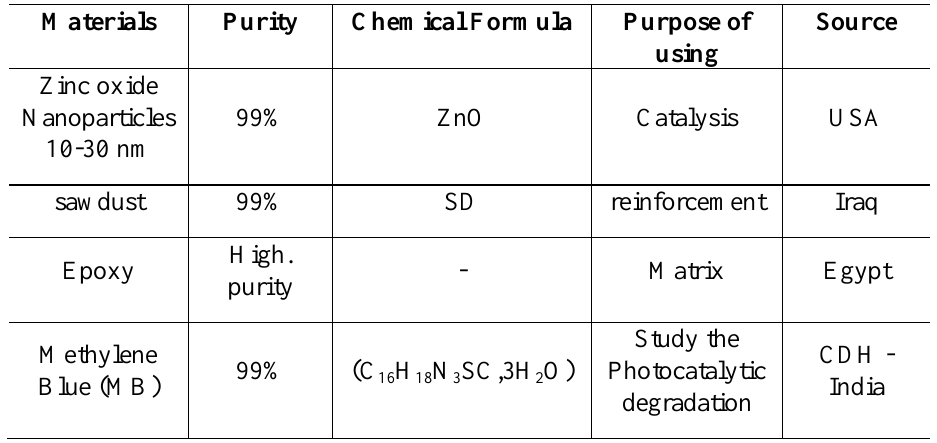
Table 1: Chemicals that were used in this